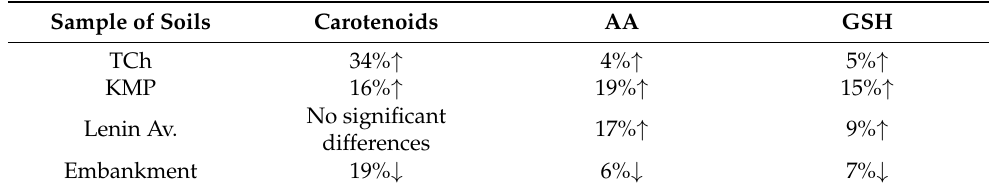
Table 9. Components of the Echinochloa frumentacea antioxidant system on soils with polyelement anomalies. Sample of Soils Carotenoids AA GSH TCh 34% ↑ KMP No significant 17% ↑ 9% ↑ Lenin Av. differences Embankment 19% ↓ 6% ↓ 7% ↓